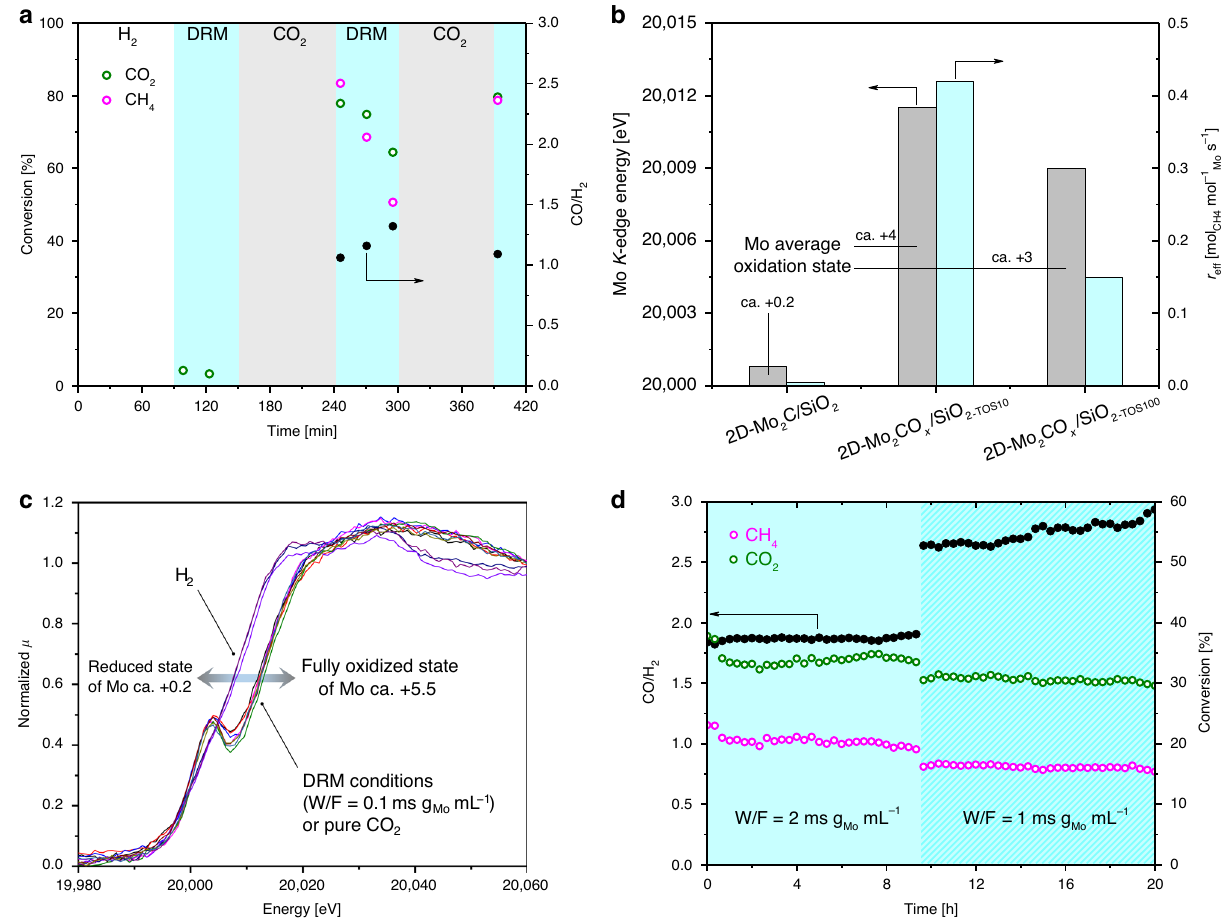
Fig. 2 Catalytic performance of 2D-Mo 2 CO x /SiO 2 in DRM. a Catalytic performance of 2D-Mo 2 C/SiO 2 (90 – 150 min) and 2D-Mo 2 CO x /SiO 2 (240 – 300 min and from 390 min after the CO 2 regeneration step) in DRM at a contact time (W/F) of 3 ms g Mo mL − 1 ; b correlation of the Mo oxidation state, determined by Mo K -edge XANES, and the catalytic activity of the material; c Mo K -edge XANES spectra of 2D-Mo 2 CO x /SiO 2 when exposed to DRM (0.1 ms g Mo mL − 1 contact time), reductive and oxidative conditions at 730 °C; d stable performance of 2D-Mo 2 CO x /SiO 2 at contact times of 1 or 2 ms g Mo mL − 1 10 min on stream at 80% CH 4 conversion (i.e., ca. 10% below the thermodynamic equilibrium in those conditions, Fig. 2a) 40 . Note